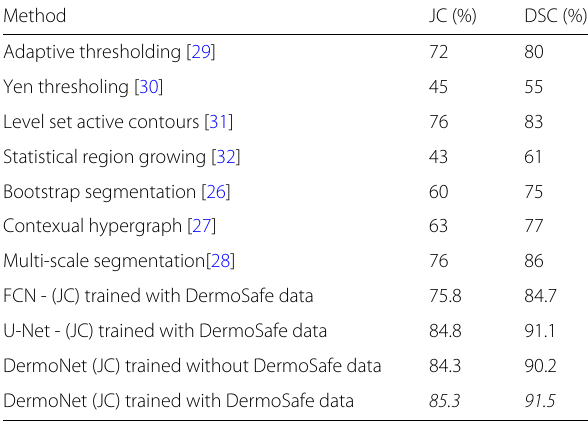
Table 5 Performance comparison between the proposed segmentation and other state-of-the-art methods on PH2 dataset Method